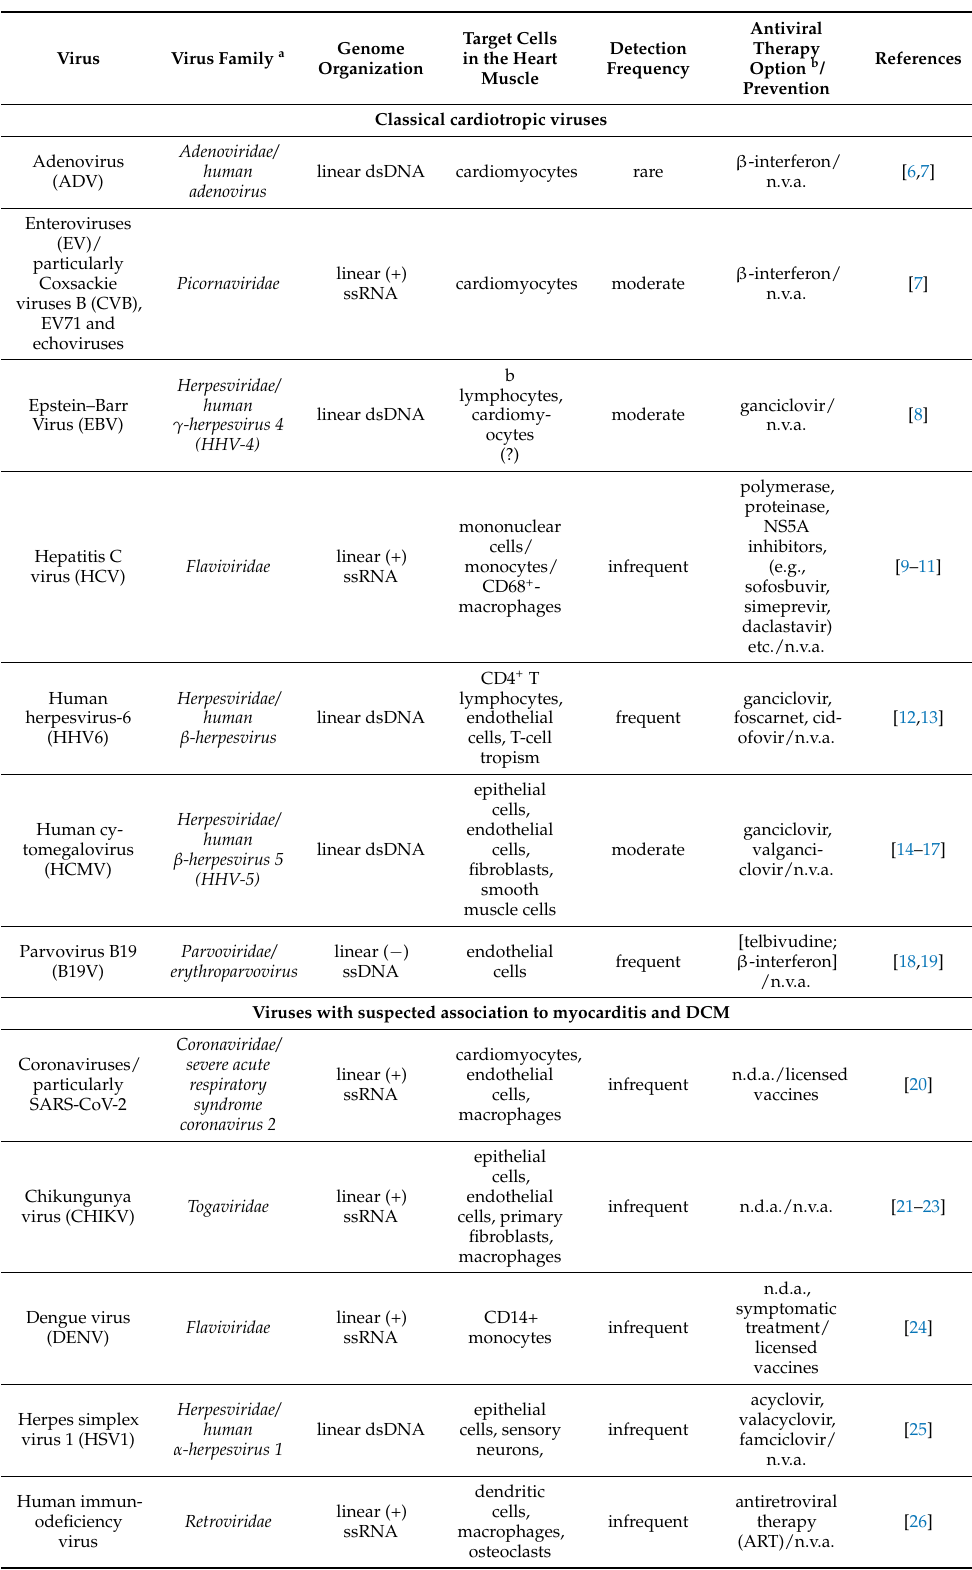
Table 1. Spectrum of viral infections in endomyocardial biopsy specimens with cardiac dysfunction in clinically suspected myocarditis and dilated